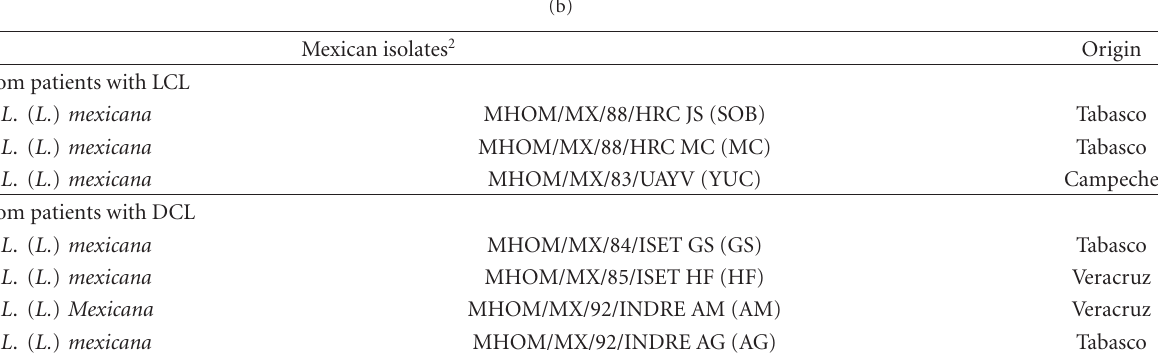
From patients with